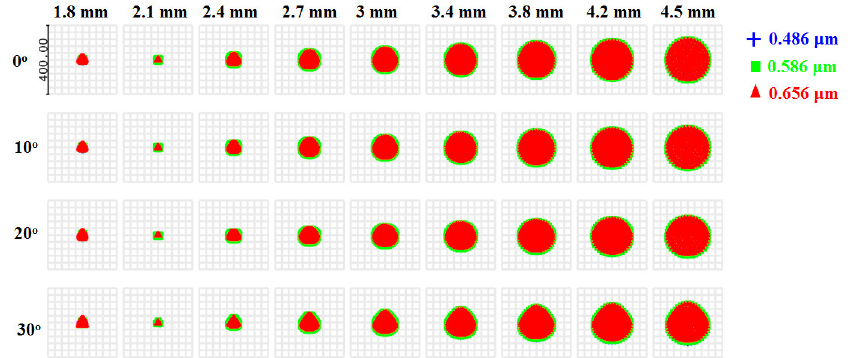
Figure 4. Spot diagrams of initial optical endoscope, varied by different object distances and FOVs. Each column stands for the same object distance (e.g., 1.8 mm), and each line stands for the same FOV (e.g., 0 ◦ ). The blue cross, green square and red triangle represent the 0.486 µ m, 0.586 µ m and 0.656 µ m incident